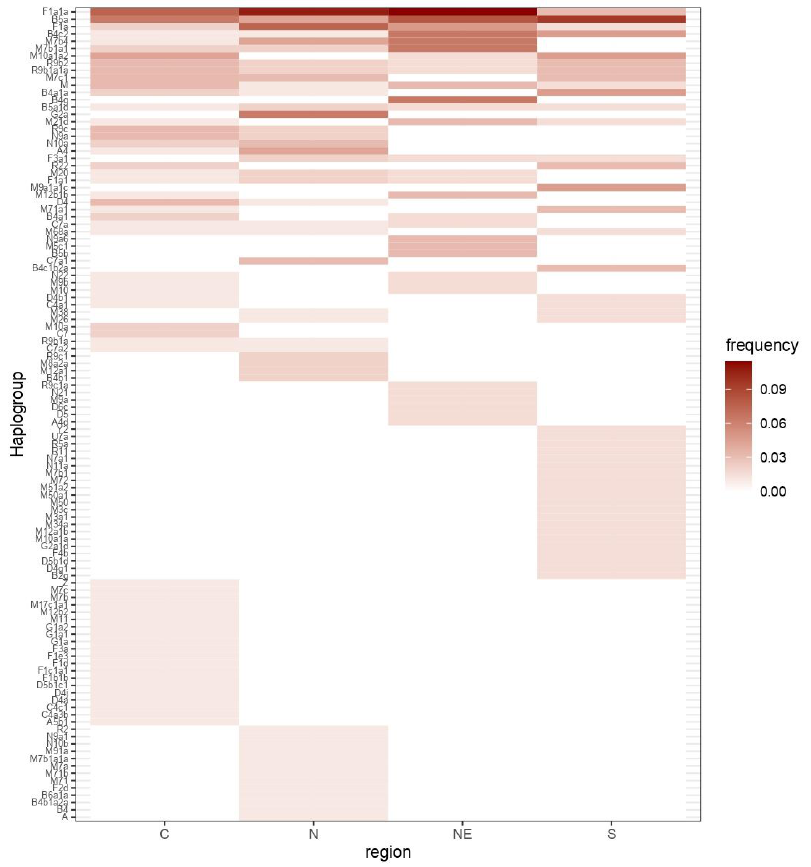
Figure 3. Heatmap of haplogroup frequencies among Thai populations in the four regions. Darker color indicates higher frequencies.